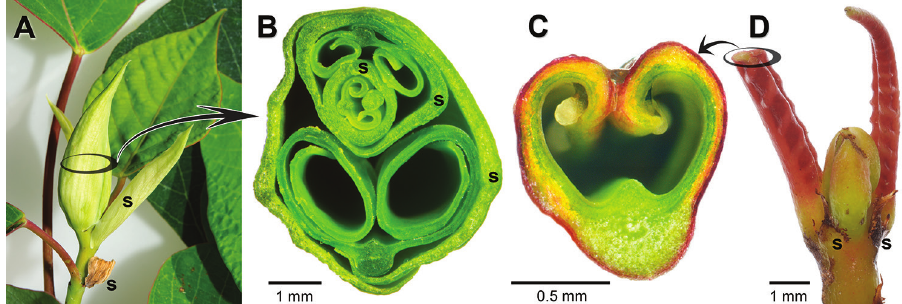
Figure 5. Hippomaneae shoot tips showing stipule and ptyxis variation. A Homalanthus nutans (G. Forst.) Guill. with large, deciduous, sheathing stipules protecting shoot tip B Transverse view of H. nutans shoot tip, showing nested series of three developing leaves with scroll-like lamina (ptyxis involute), each surrounded by a pair of sheathing stipules C Transverse view of Excoecaria cochinchinensis Lour. young leaf showing slightly inrolled lamina (ptyxis conduplicate-involute) D E. cochinchinensis shoot tip with small persistent stipules. (Abbreviation: s = stipule. Source: Freehand sections of fresh tissues grown in Depart- ment of Botany